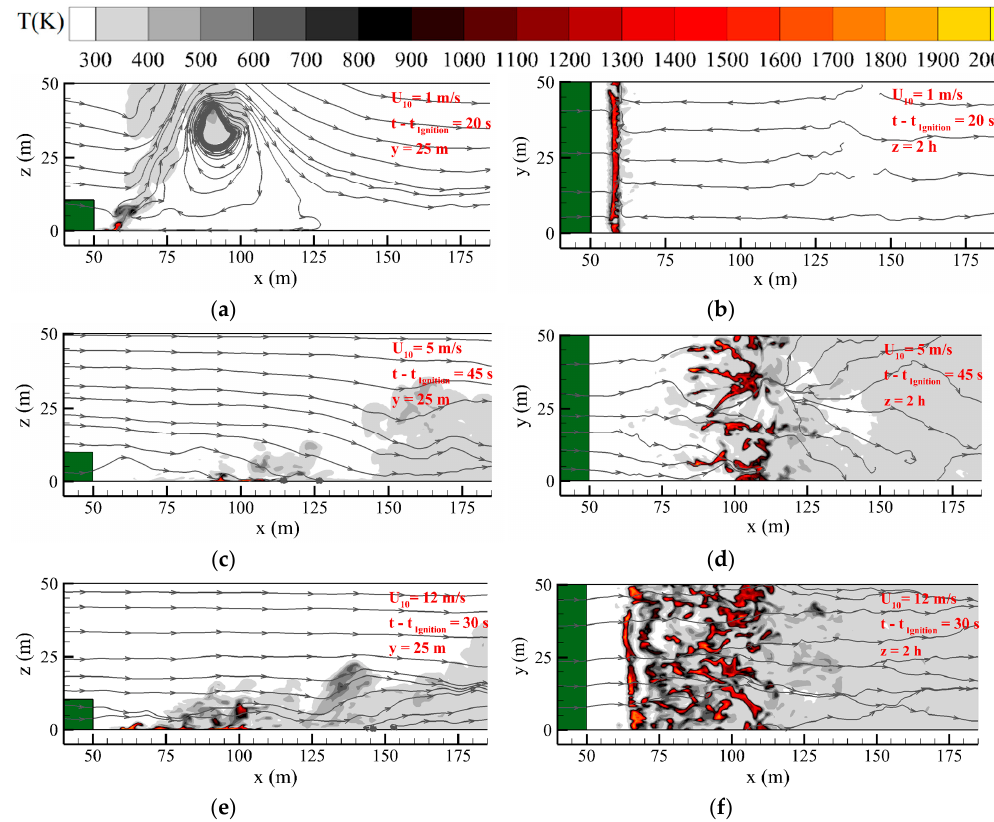
Figure 10. Cuts in the vertical-median plane y = 25 m ( a, c, e ) and in the horizontal plan z = 2 h ( b, d, f ) of the temperature field with streamlines obtained for U 10 = 1 m/s (a, b), 5 m/s (c, d), and 12 m/s (e, f). The fire-front location (relative to the ignition line) was determined by finding, at each time step, the average position of the most remote points at the grassland surface downstream the ignition line that are characterized by zero dry-material mass fraction (i.e., pyrolysis front at the grassland surface). An example contour diagram showing the fuel composition is presented in Figure 11. The front location (average of the pyrolysis front position in the y -direction at the grassland surface) is shown in Figure 12 as a function of time. The U 10 = 1 m/s case extinguishes at approximately 15 m downstream of the ignition location. The wind velocity at flame height is very low (see Figure 8b) and is likely insu ffi cient to sustain a propagating fire in this particular fuel bed. All other cases propagate to the